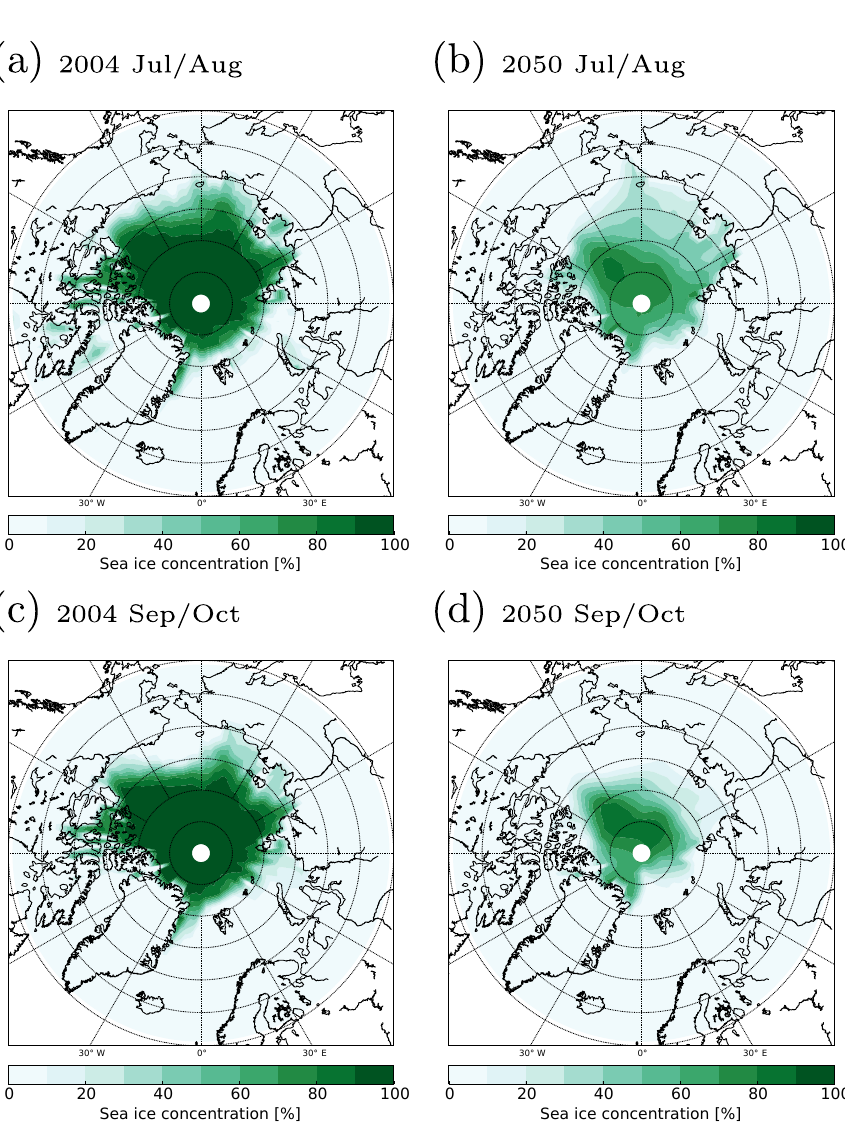
Figure 2. SIC in 2004 and 2050 for late summer (July–August) and for early autumn